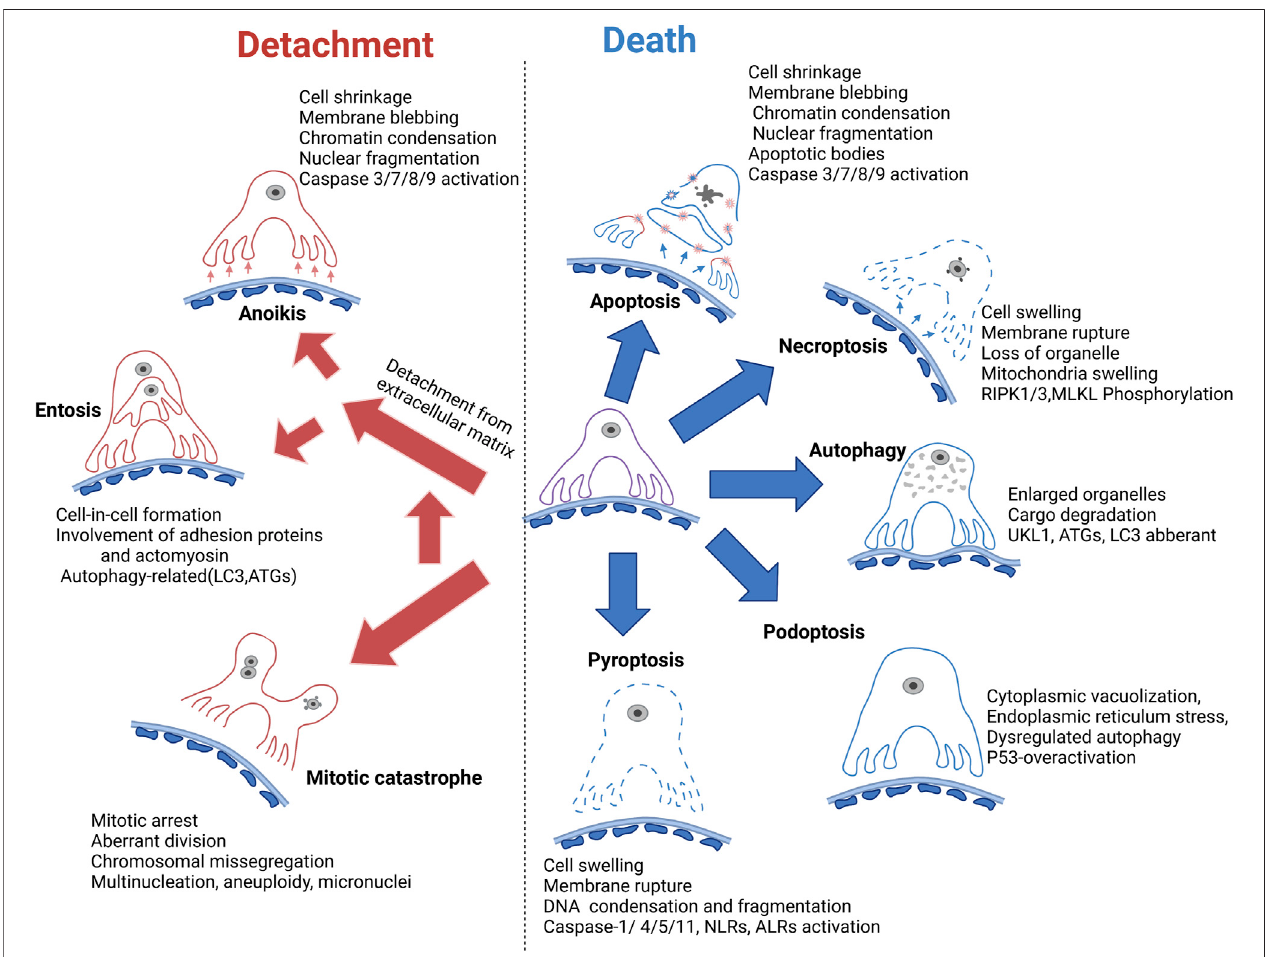
FIGURE 3 | Mechanism of podocyte loss. Apoptosis is previously considered the common form of podocyte death; however, the in vivo evidence is lacking. Autophagy dysregulation related cell death is generally accepted as a major mechanism of podocyte cell death. Necroptosis, podoptosis, and pyroptosis are also involved in podocyte death. Meanwhile, podocyte detachment and detachment-induced cell death such as anoikis and entosis remain the major mechanism of podocyte loss. Mitotic catastrophe could promote podocyte detachment from GBM. GBM, glomerular basement membrane. RIPK, receptor-interacting protein kinase 1; MLKL, mixed lineage kinase domain-like pseudokinase; UKL1, unc-51 like autophagy activating kinase 1; LC3, microtubule-associated protein light chain 3; ATGs, autophagy-related proteins; NLRs, NOD-like receptors; ALRs, AIM-2-like receptors.